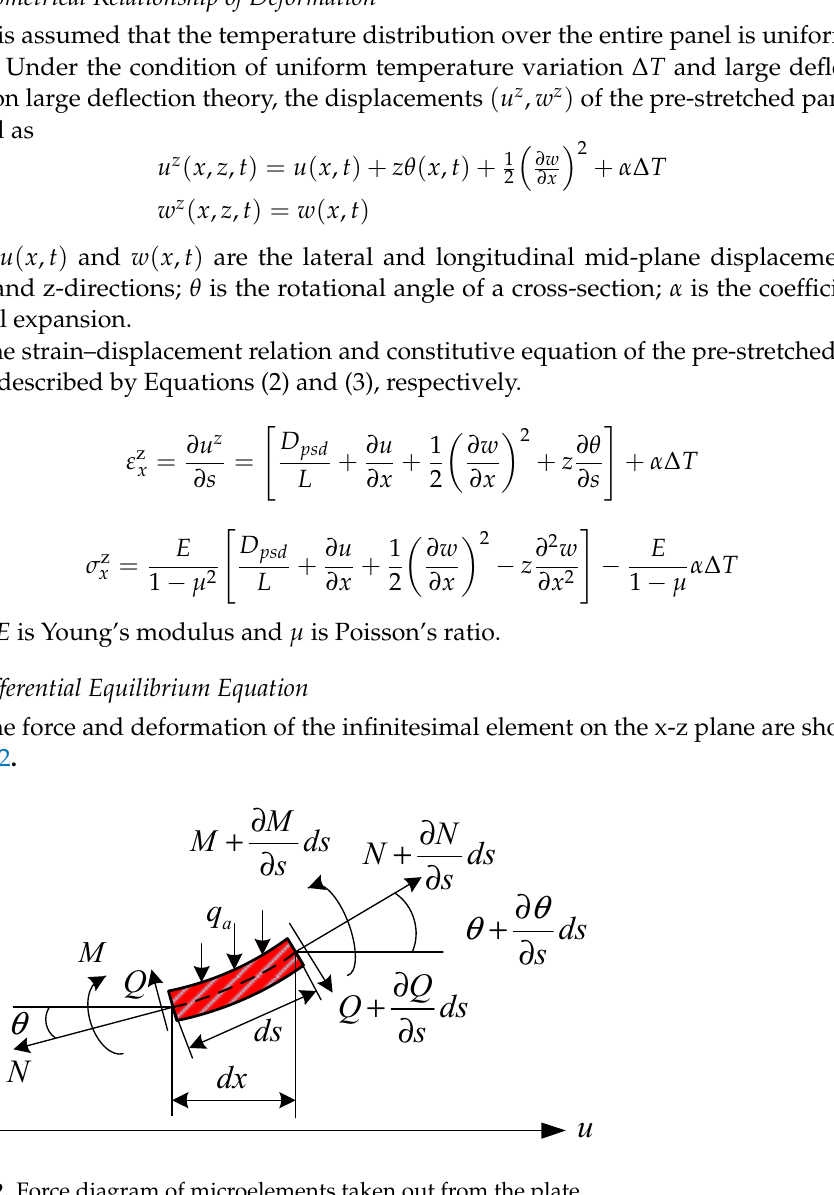
where ds = dx / cos θ , A is the panel cross-section A = bh = h , Q is the shear force in the panel element and N is the in-plane force in the panel element. The moment at the left end of the infinitesimal element is − M , the moment at the ds and the moment of shear force Q about the right endpoint is − Qds . right end is M + ∂ M ∂ s Ignoring the moment of inertia, the moment balance equation about the right endpoint can be simplified